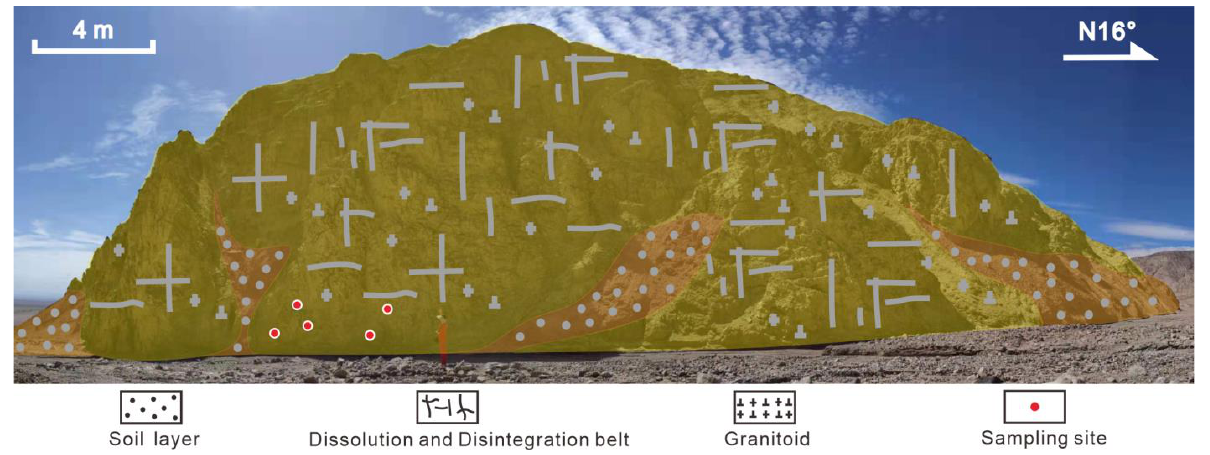
Figure 3. The weathering crust outcropped in the Datonggou area of the Qaidam